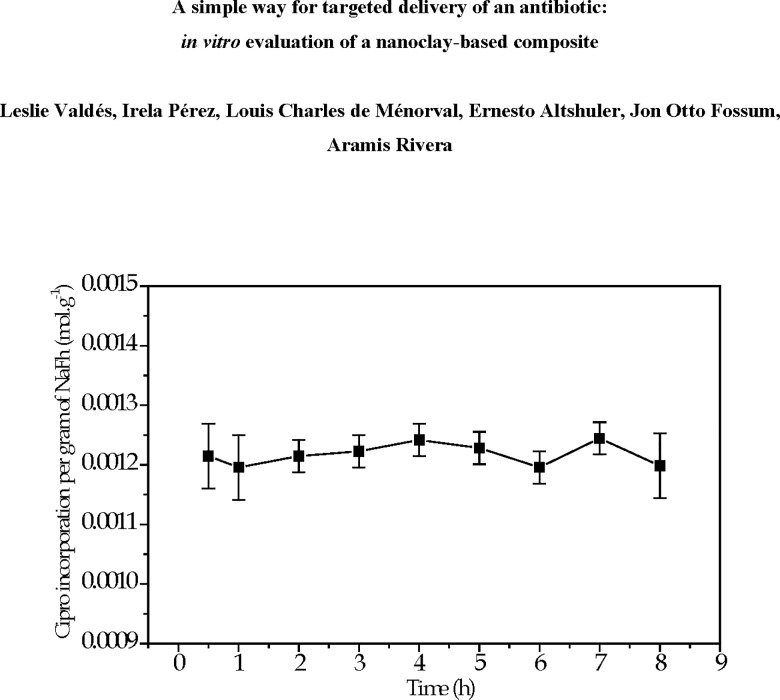
Amount of Cipro on NaFh from aqueous solution at 1.36 x 10-2mol L-1 as a function of time.The equilibration time applied was 4 h at 65 oC.